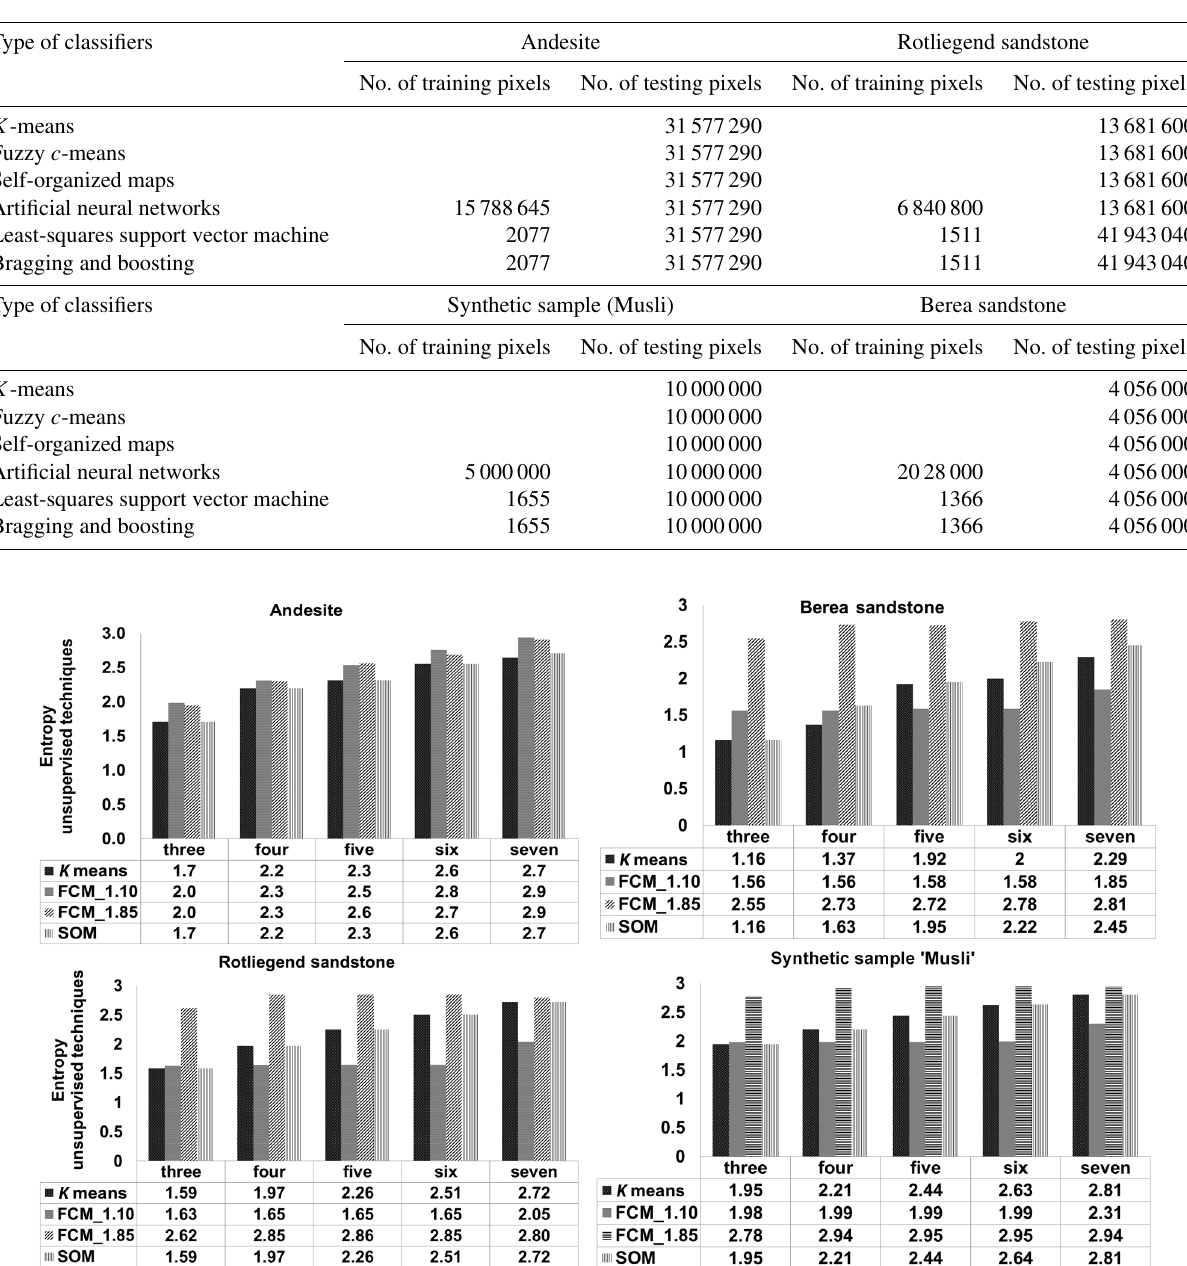
Figure 6. Entropy values of unsupervised techniques plotted for respective